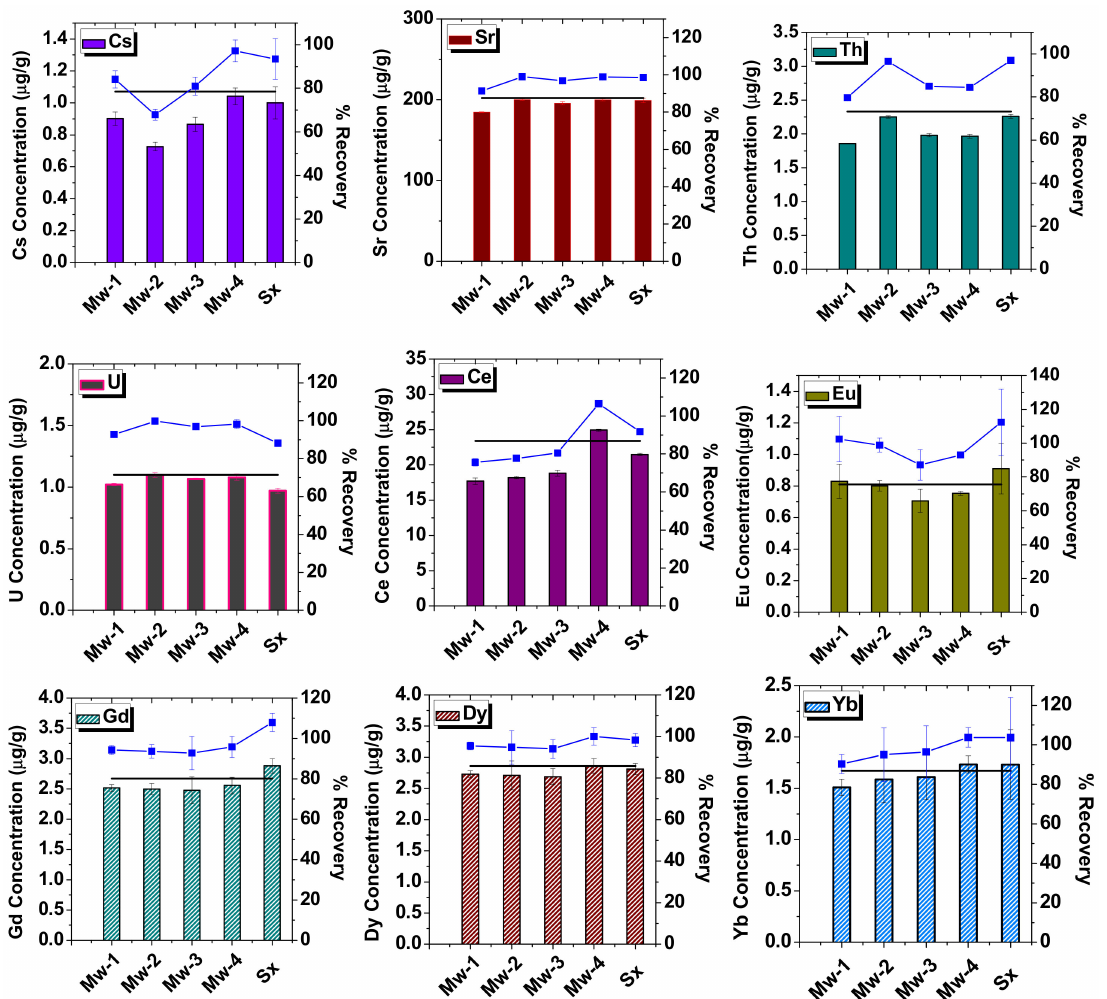
Figure 1. Comparison between microwave digestion (Mw) and Savillex digestion (Sx) for JSd-2; concentration ( µ g / g) and recovery (%) of Cs, Sr, Th, U, Ce, Eu, Gd, Dy and Yb obtained after digestion (The solid line corresponds to the certified value of the respective metal. Errors in the method of analysis are represented as SD. n =